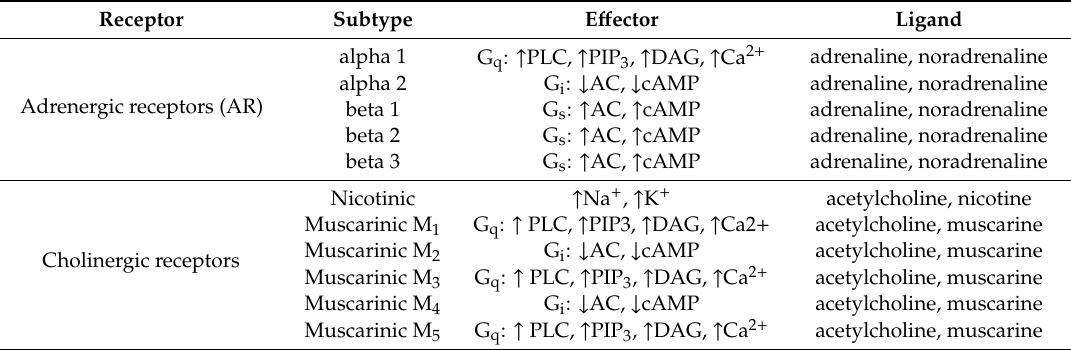
Table 1. Summary of adrenergic and cholinergic receptor subtypes, e ff ectors and ligands. Receptor Subtype E ff ector Ligand alpha Adrenergic receptors (AR)